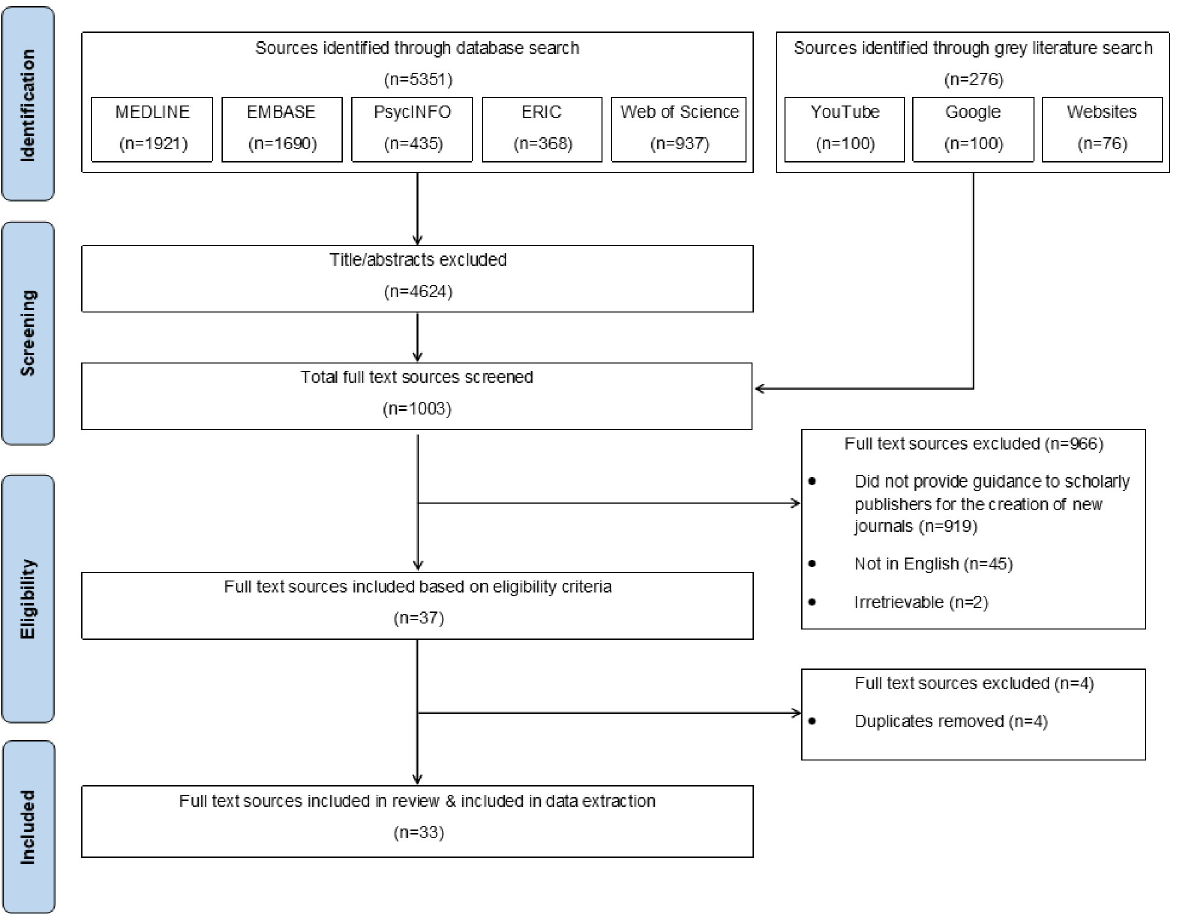
Fig 1. PRISMA flow diagram summarizing search process and source